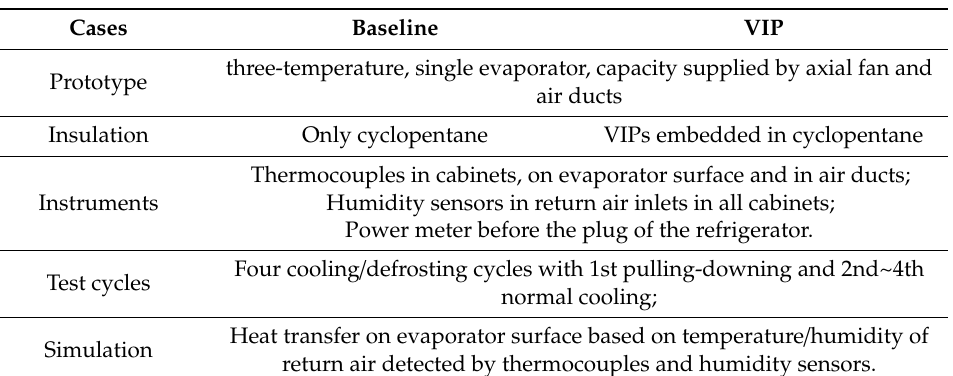
Table 2. Test scenarios of this research.